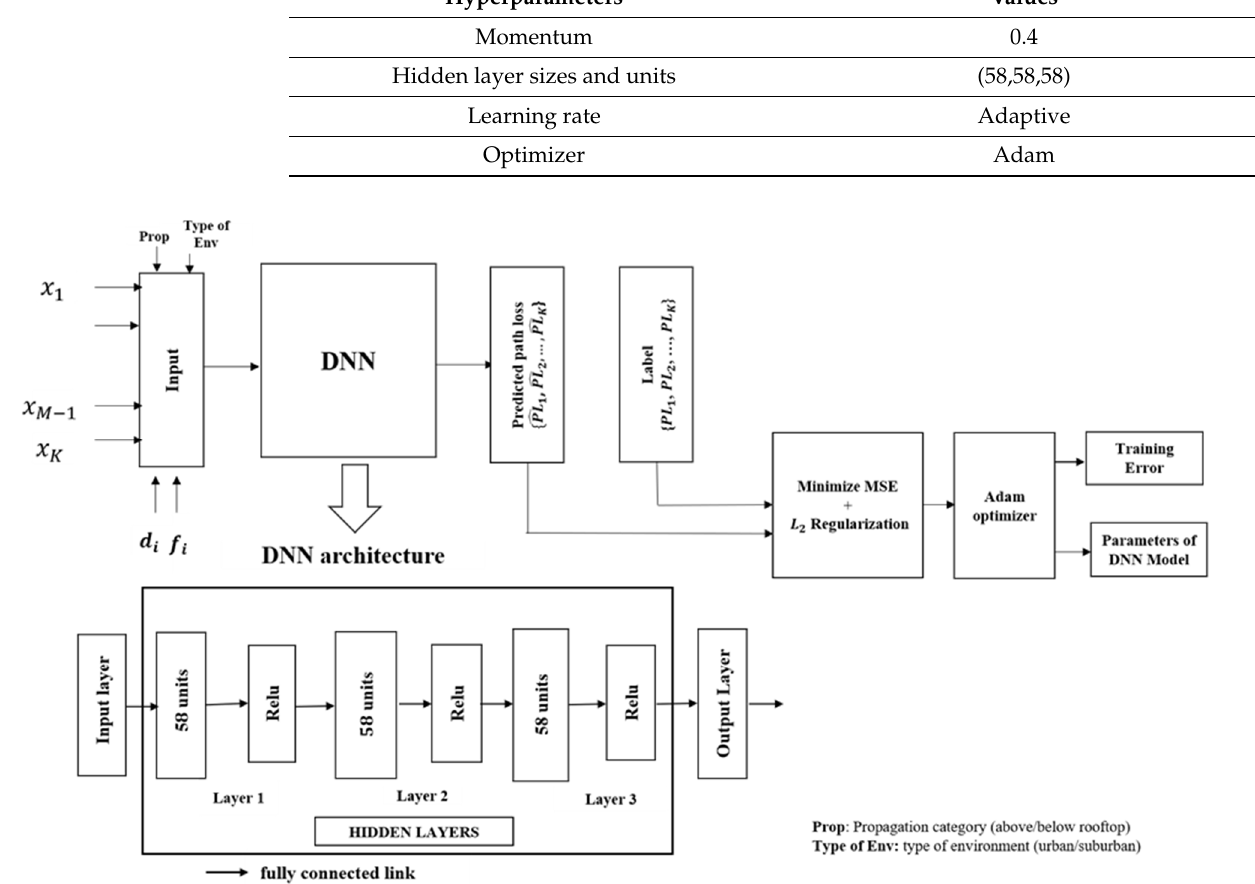
Figure 7. Proposed fully connected DNN model.